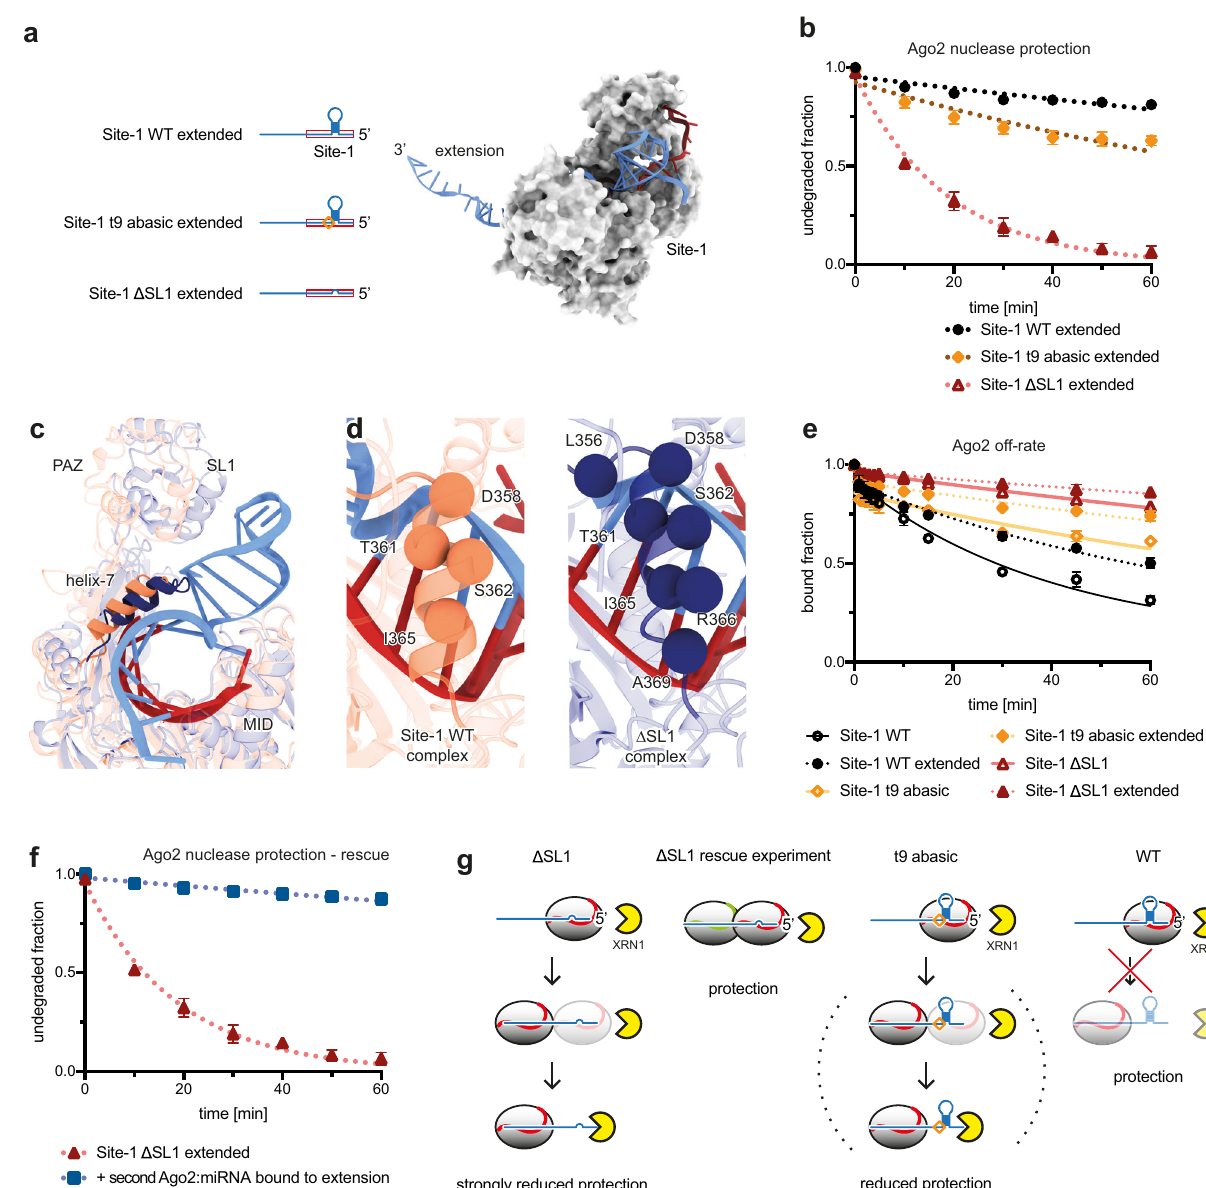
Fig. 4 SL1 protects from XRN1 by attenuating Ago2 lateral diffusion. a Cartoons of extended Site-1 WT, Δ SL1 and t9 abasic RNA constructs (blue). Red box indicates Site-1. Model of the extended Site-1 WT (blue ribbon) in complex with Ago2:miR-122, to illustrate the relative size of the 3 ’ extension. b XRN1 mediated degradation of 3 ’ extended Site-1 WT, t9 abasic, and Δ SL1 in the presence of Ago2:miR-122 over time. Data are shown as means of 3 independent replicates with error bars representing SEM. c PAZ domain and helix-7 positions (relative to MID-PIWI lobe) in structures of Ago2:miR-122 bound to HCV Site-1 (coral), or seed plus supplementary paired RNA (dark blue, PDB code 6N4O). d Comparison of the Ago2 helix-7-target RNA contacts (spheres centred at C α atoms in contacting residues) for the Site-1, and seed plus supplementary paired RNA. The miRNA strand is coloured red and the target strand blue (only seed base pairs shown). e Release of Site-1 WT, Δ SL1, and t9 abasic Site-1 RNAs, with and without 3 ’ extensions, from Ago2:miR-122 over time. Data are shown as means of 3 independent replicates with error bars representing SEM. f XRN1 mediated degradation of extended Site-1 Δ SL1 RNA in presences of Ago2:miR-122-wt alone or in combination with Ago2:miR-122-mut (targeting the 3 ’ extension). Data are shown as means of 3 independent replicates with error bars representing SEM. g Cartoon representation of the proposed mechanism. Ago2:miR-122 transiently diffuses onto 3 ’ extensions in the absence of SL1, allowing XRN1 access to the HCV RNA 5 ’ end (left). The presence of a second Ago2:miRNA can prevent lateral diffusion, re-establishing protection (middle-left). Ago2:miR-122 also laterally diffuses from a Site-1 with a t9 abasic nucleotide, albeit at a reduced rate compared with the Δ SL1 construct, again enabling XRN1(middle-right). The full motif at Site-1 prevents Ago2:miR-122 lateral diffusion, and the target RNA is protected